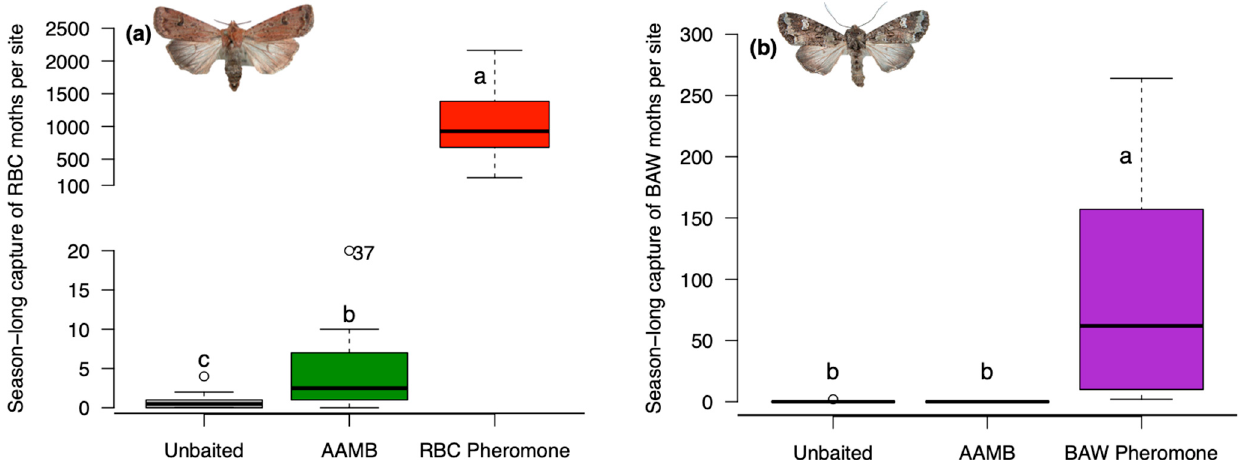
Figure 1. Experiment 1—box-and-whisker plot of the season-long capture of targeted moths in baited traps at seven sites in central Alberta, Canada: ( a ) redbacked cutworm (RBC); ( b ) bertha armyworm (BAW). Open circles represent points more than 1.5 times the interquartile range. Traps were baited with either a sex pheromone, acetic acid and 3-methyl-1-butanol (AAMB) lure or left unbaited as control trap. There was no difference in moth trap catch between canola or wheat fields. Means comparisons were performed for differences in season-long trap capture. Boxplots marked with different letters are statistically different (Tukey method, α = 0.05). (Open circle beside number 37 is data point out of y-axis range in Figure 1a)